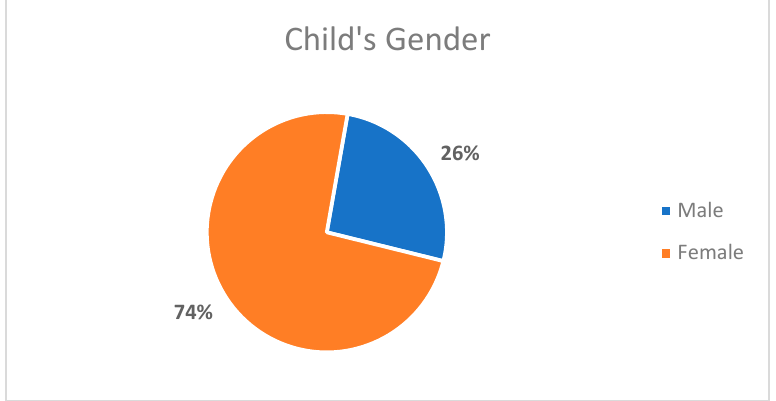
Figure 2. Distribution of the sample of children by gender ( n = 23).